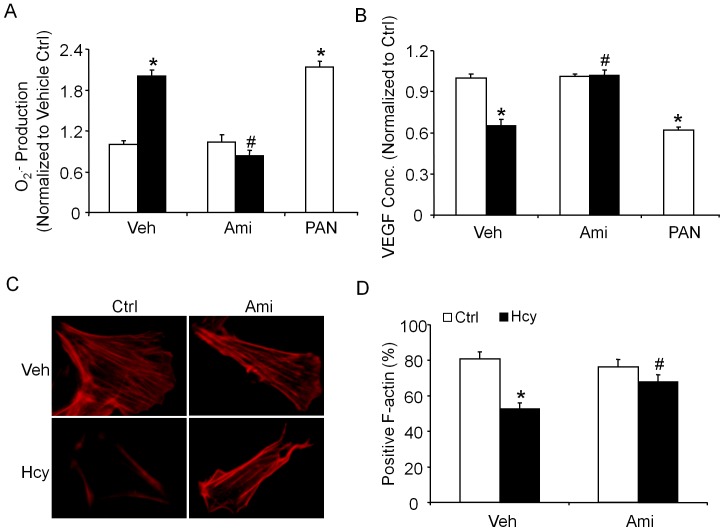
O2. – production and VEGF levels in podocytes with or without Hcys and/or amitriptyline treatment.Cultured podocytes were treated with or without Hcys for 24 h. Values are arithmetic means ± SE (n = 5 each group) of O2.− production (A), VEGF levels (B) in podocytes with or without Hcys and/or amitriptyline treatment. C. Representative microscopic images showing F-actin staining in podocytes using rhodamine-phalloidin staining (magnification, ×400). D. Summarized data showing the rate of podocytes retaining distinct longitudinal stress fibers. Scoring was from 100 podocytes on each slide in different groups (n = 5 each group). Ctrl: Control, Hcy: Homocysteine, Ami: Amitriptyline, Veh: Vehicle. * Significant difference (P<0.05) compared to the control group; # Significant difference (P<0.05) compared to the Hcys group.